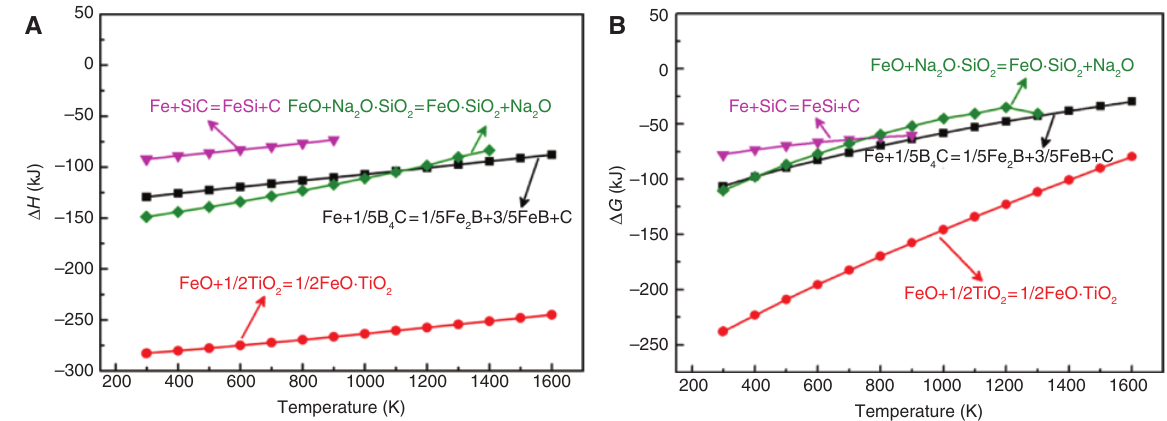
Figure 10: Relationship between temperature and reaction enthalpy or Gibbs free energy: (A) temperature and reaction enthalpy; (B) temperature and Gibbs free energy.